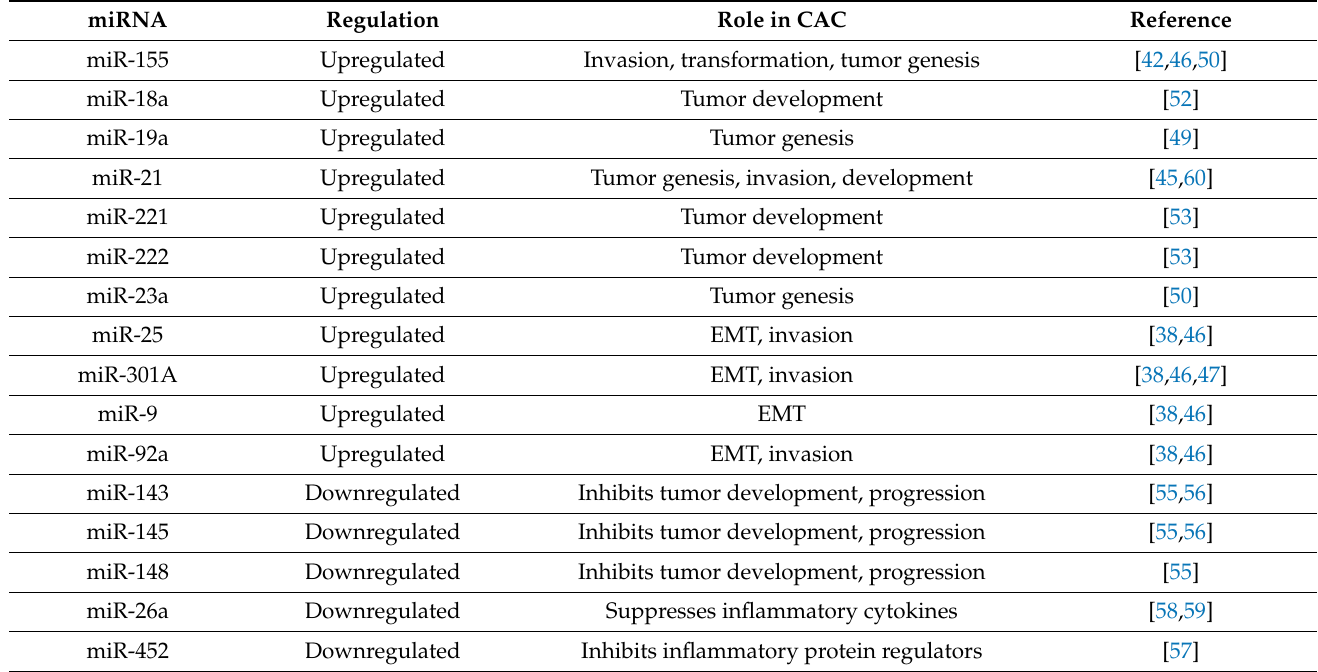
Table 3. miRNAs significantly upregulated or downregulated within CAC and their respective roles. Role in